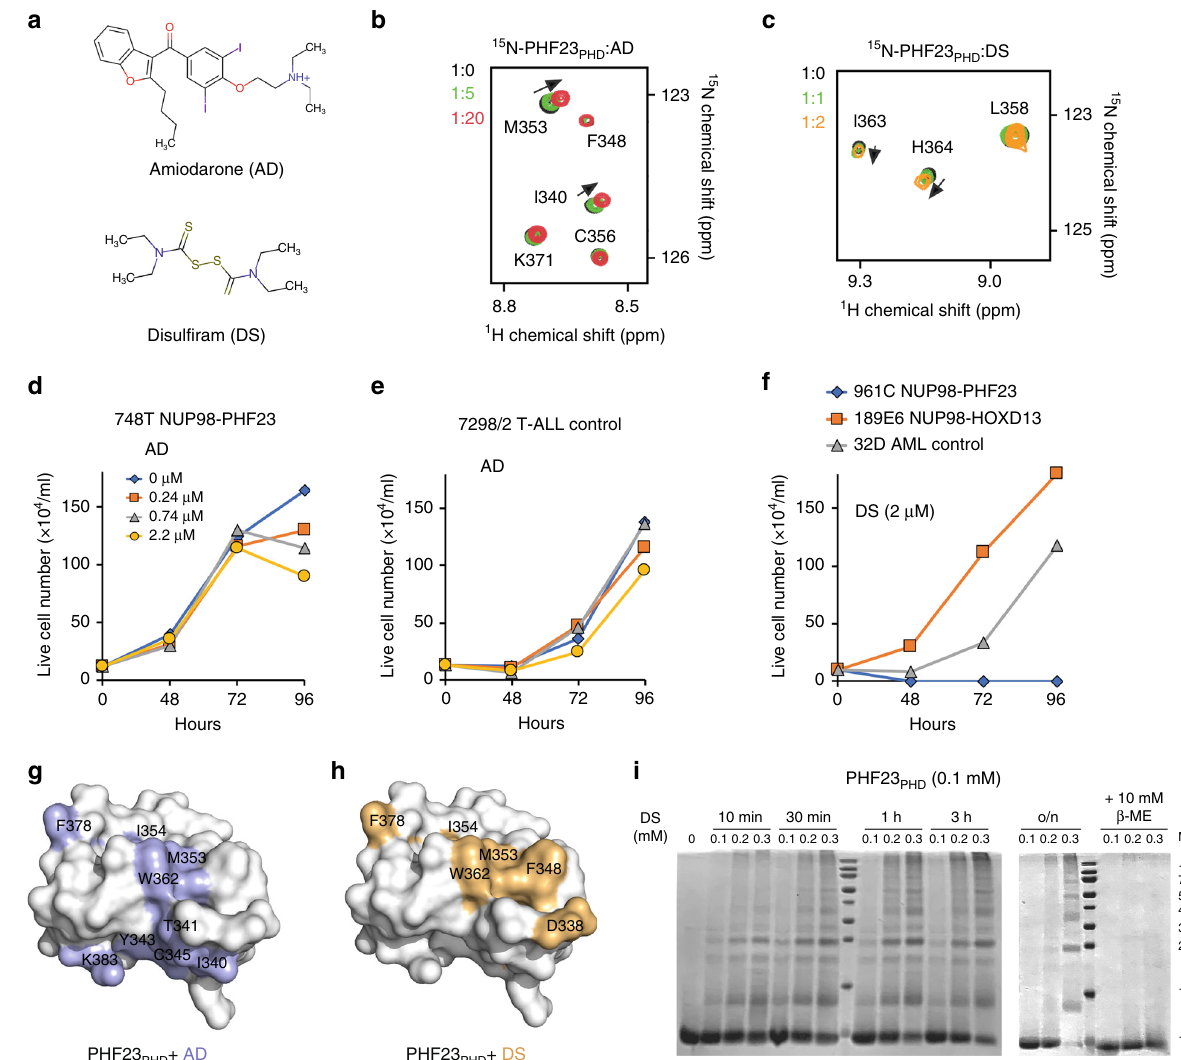
Fig. 3 AD and DS bind to PHF23 PHD and inhibit the survival of NUP98 – PHF23 expressing AML cells. a Chemical structures of amiodarone and disul fi ram. b , c Superimposed 1 H, 15 N HSQC spectra of PHF23 PHD collected upon titration with AD or DS. Protein concentration was kept at 100 μ M. Concentrations of AD were 0, 0.5, and 2 mM b . Concentrations of DS were 0, 0.1, and 0.2 mM c . Spectra are color coded according to the protein: compound molar ratio. d , e AD treatment affected the survival of NUP98 – PHF23 (748T) and control (7298/2) cell lines. For additional trials see ref. 9 . Source data are provided in the Source Data fi le. f Concentration dependent effect of DS on the survival of NUP98 – PHF23 expressing 961C, NUP98 – HOXD13 expressing 189E6, and 32D AML cell lines. For additional trials see ref. 9 . Source data are provided in the Source Data fi le. Identi fi cation of the AD-binding g and DS-binding h sites of PHF23 PHD . Residues that exhibit signi fi cant ligand-induced resonance perturbations in b , c are mapped onto the structure of PHF23 PHD . See also Supplementary Fig. 4. i Samples containing 0.1 mM PHF23 PHD were incubated with indicated amounts of DS for 10 min, 30 min, 1 h, 3 h, and overnight (o/n). All samples were fl ash-frozen and resolved by SDS-PAGE under nonreducing and reducing (10 mM mercaptoethanol ( β -ME)) conditions. Experiment was repeated independently two times with similar results. compound ratio of 1:3 (Fig. 3i). Markedly, the PHF23 PHD ladder (Fig. 3g, h and Supplementary Fig. 4). Addition of excess DS (ratio of 1:3) or AD (ratio of 1:50) led to disappearance of amide reso- bands disappeared upon addition of the reducing agent, β - nances of PHF23 PHD , indicating the formation of high molecular mercaptoethanol ( β -ME). These results suggest that at high con- weight species that exceed detection limit of NMR. Subsequent centration and over time DS reacts with zinc chelating Cys residues analysis of the reaction mixtures by SDS-PAGE gel electrophoresis of PHF23 PHD generating covalently linked intermolecular oligomers (Fig. 4a). Although we cannot exclude the formation of the intra- revealed distinct modes of action for these compounds. We molecular intermediates, in either case the DS activity would result observed a single band corresponding to the size of a monomeric in eventual and permanent disruption of the PHF23 PHD fold. protein in the PHF23 PHD :AD sample resolved on a nonreducing SDS-PAGE gel (Supplementary Fig. 5). We concluded that at high concentrations, AD stimulates non-covalent oligomerization of PHF23 PHD . In contrast, in the presence of DS, nonreducing SDS- PAGE gels showed a ladder of protein oligomers, clearly observed after 30 min incubation of PHF23 PHD with DS at a protein: NATURE COMMUNICATIONS| (2020) 11:3339